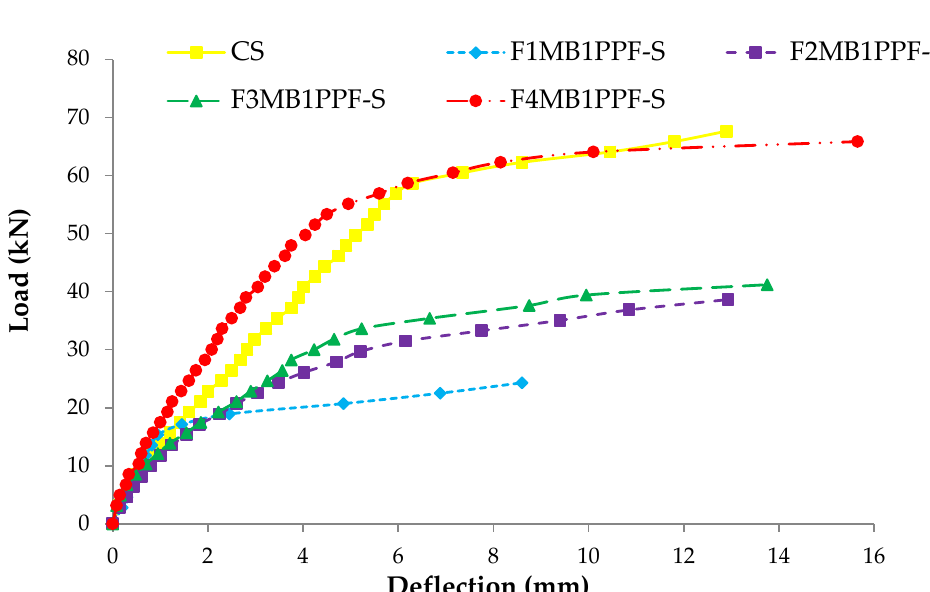
Figure 12. Comparison of load-deflection of group B1 with CS slab.